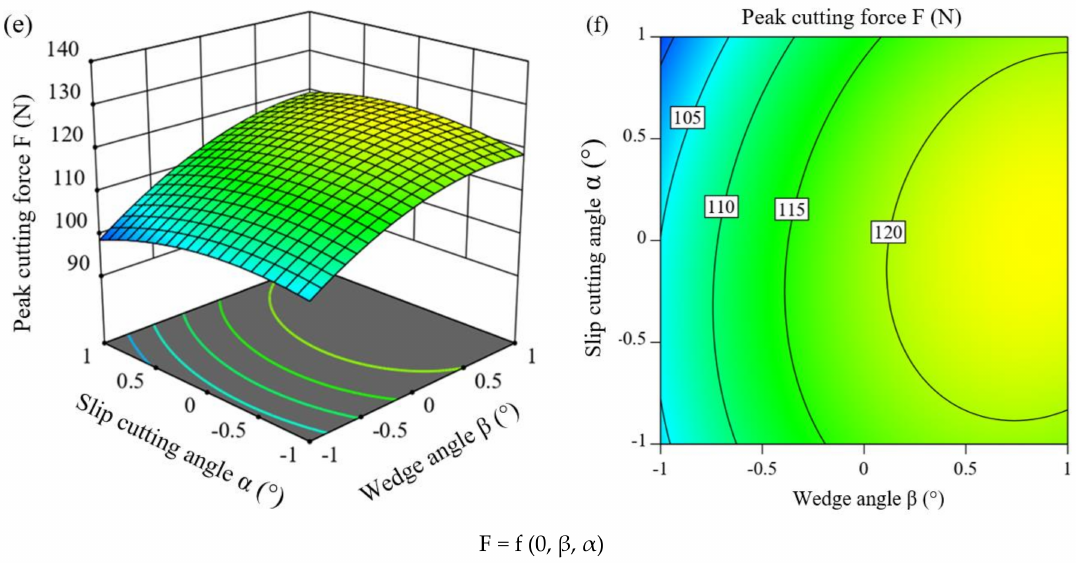
Figure 21. Response surface of interaction to peak cutting force (unsupported cutting). ( a ) Response surface under the interaction of Average cutting speed and Wedge angle. ( b ) Contour plot under the interaction of Average cutting speed and Wedge angle. ( c ) Response surface under the interaction of Average cutting speed and Slip cutting angle. ( d ) Contour plot under the interaction of Average cutting speed and Slip cutting angle. ( e ) Response surface under the interaction of Slip cutting angle and Wedge angle. ( f ) Contour plot under the interaction of Slip cutting angle and Wedge